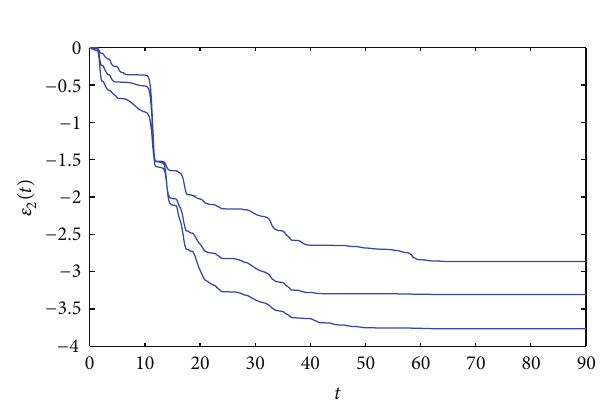
Figure 5: The curve of 𝜀 2 (𝑡)